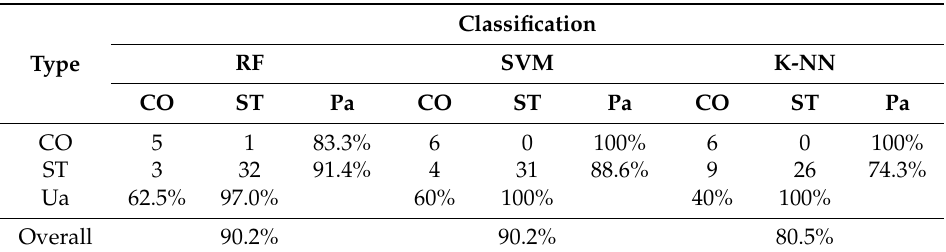
Table 5. Classification results of Image 1 using different methods (CO = totally collapsed building, ST = standing building; Pa = producer’s accuracy, Ua = user’s accuracy).